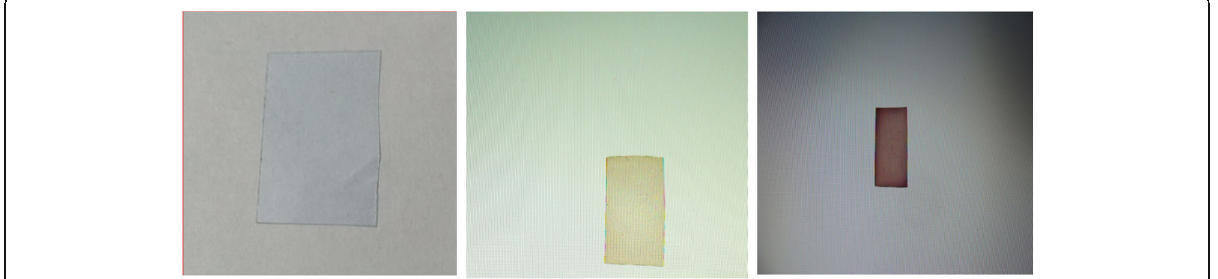
Fig. 2 Change in color of films sorbed with I 3 − and after treatment with variamine blue